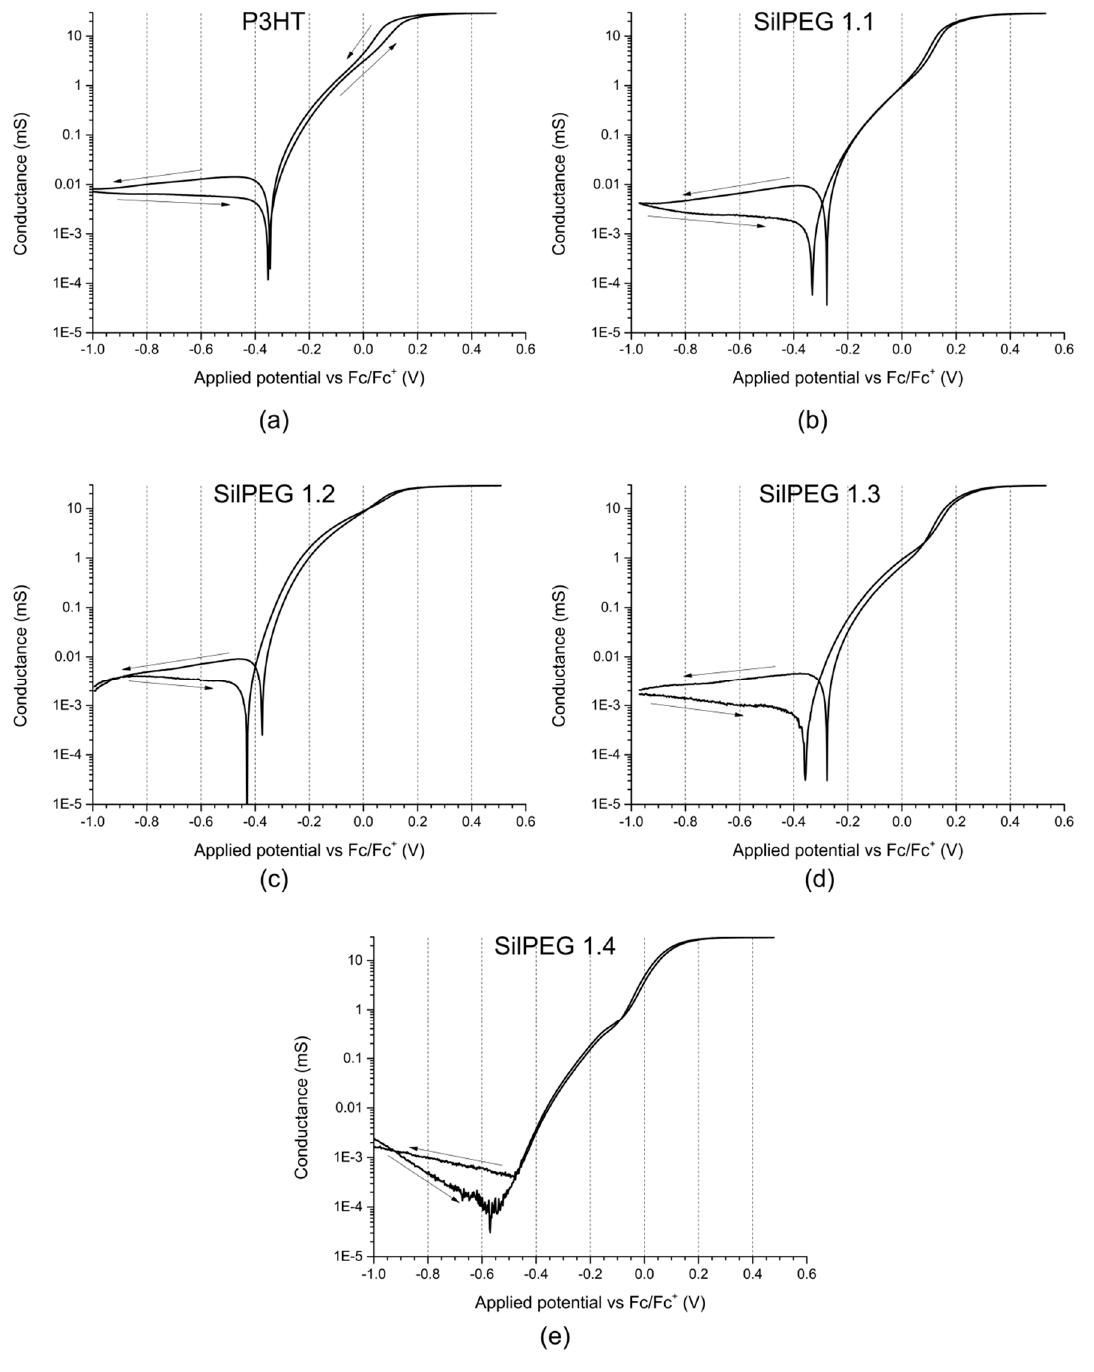
Figure 5. Conductance of ( a ) P3HT; ( b ) SilPEG1.1; ( c ) SilPEG1.2; ( d ) SilPEG 1.3; ( e ) SilPEG 1.4.